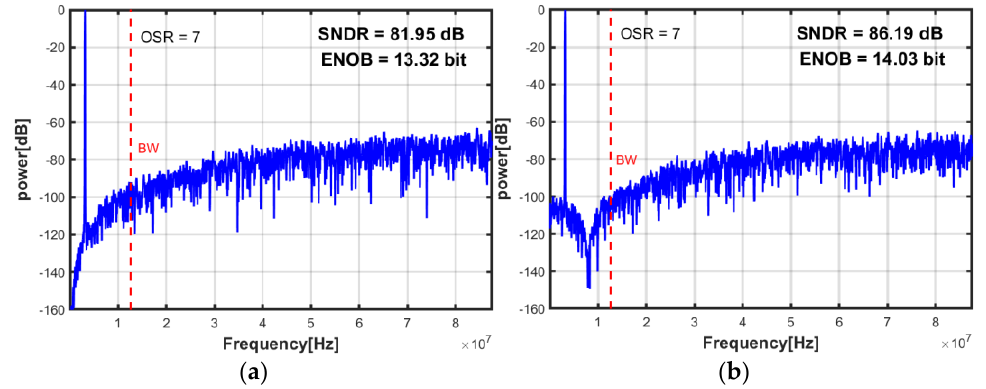
Figure 4. Power spectral density ( a ), with zero located at 1 ( b ) with zero optimization.